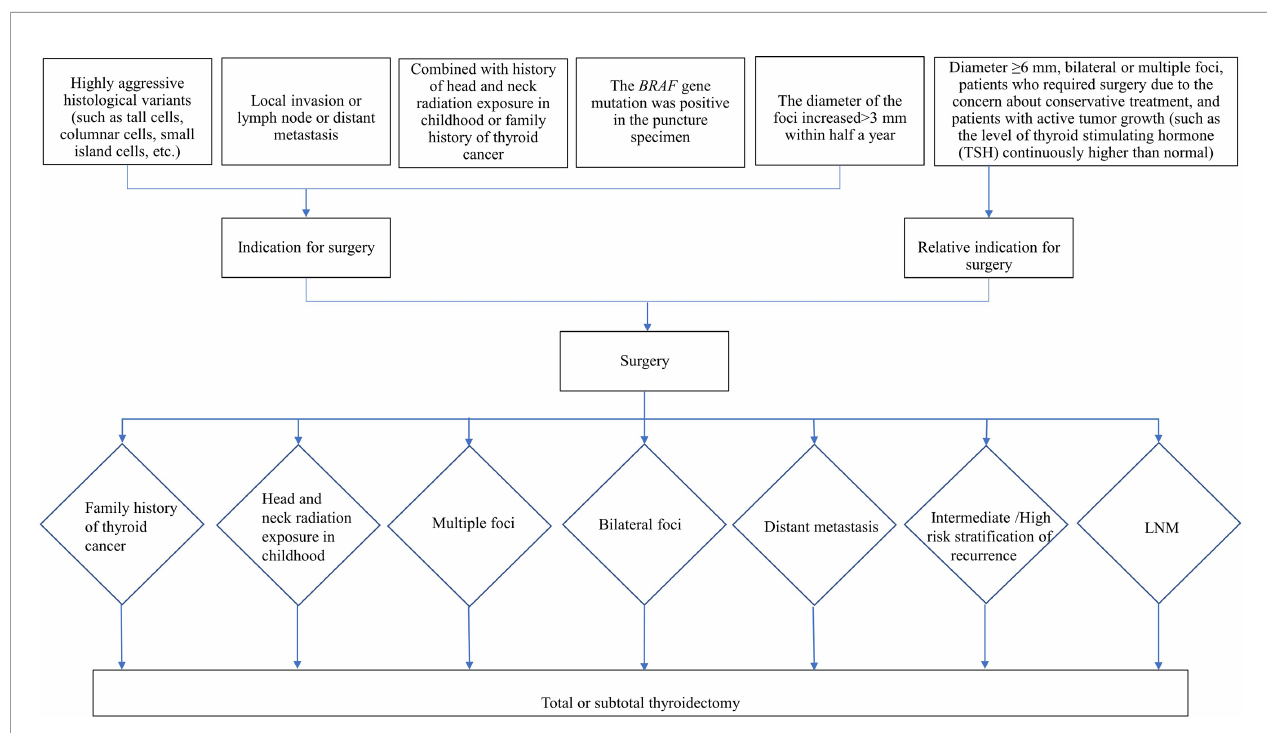
FIGURE 1 | Indications for surgery and for total or subtotal